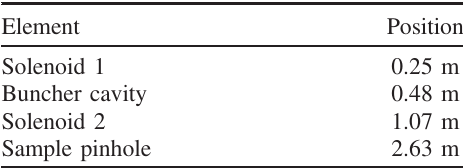
TABLE III. Average optimized beam line element positions.